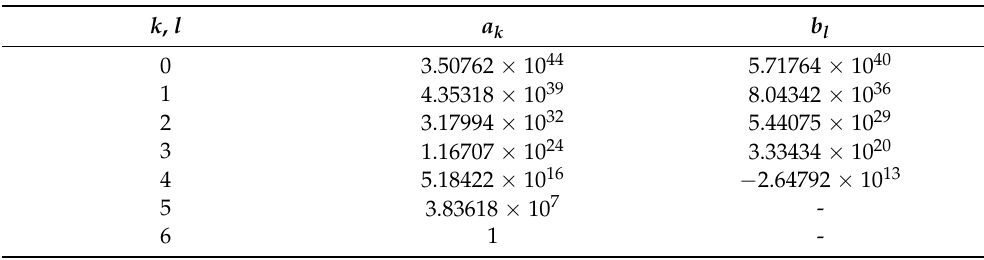
Table 1. Values of polynomial coefficients of the equivalent transmittance of a voltage sensor with resistive divider structure.